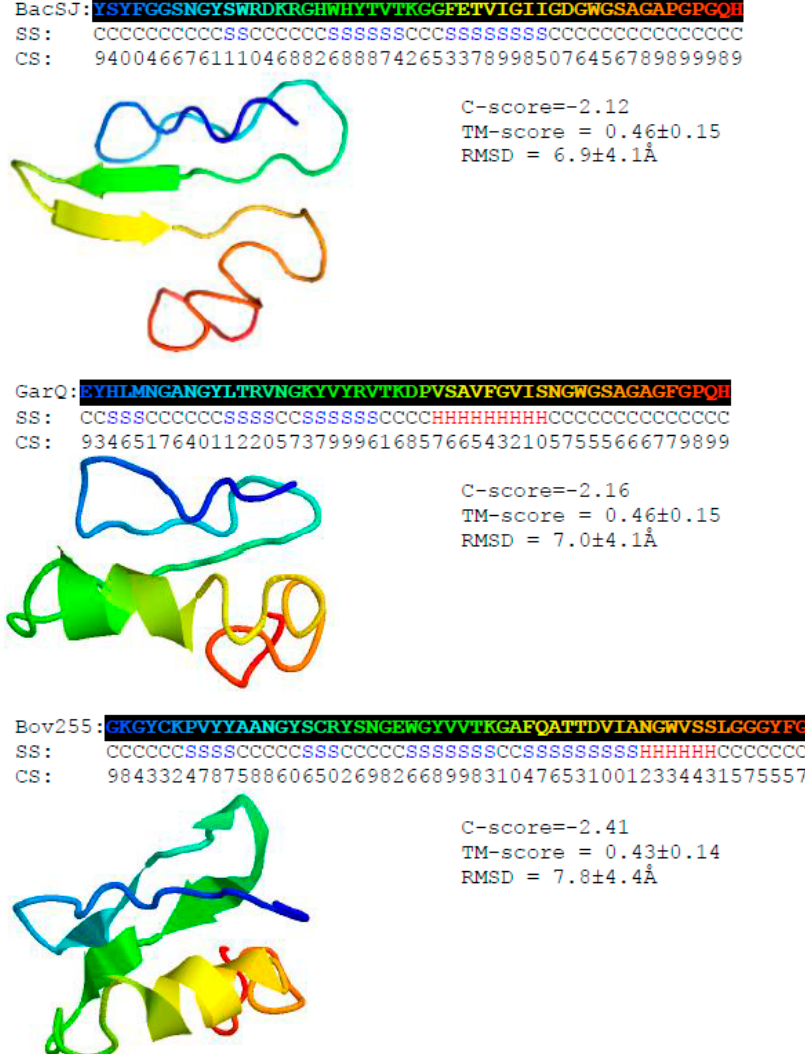
Figure 2. Predicted secondary and tertiary structures of BacSJ, Bov255, and GarQ. H, S, and C indicate helix, strand, and coil, respectively. The confidence score (CS) ranges from 0 to 9 and represents the certainty of the secondary structure (SS) prediction. C- and TM-scores estimate the global accuracy of the 3D structure model. C-score in the range from − 5 to 2 and TM-score > − 1.5 indicates a model with a correct global topology. Root mean square distance (RMSD) is the average distance of pairs of residues between model and template.